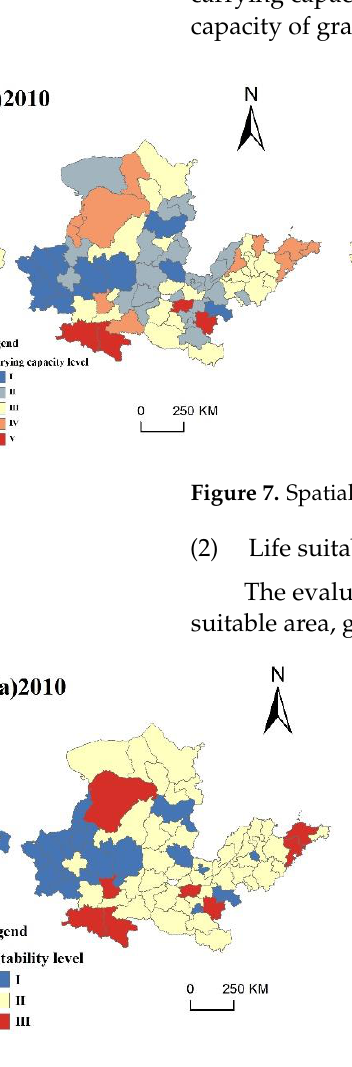
Figure 8. Spatial pattern of living suitability from 2010 to 2020.